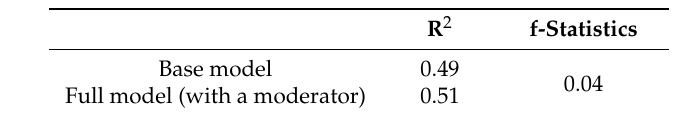
Table 9. Interaction effects